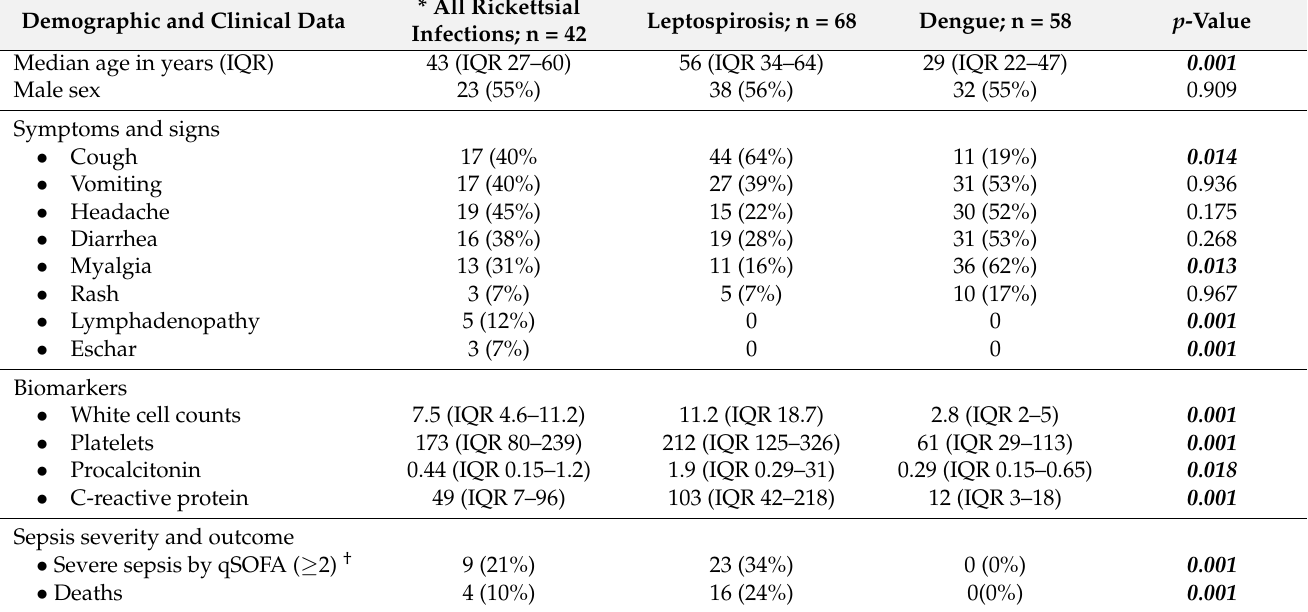
Table 2. Demographic and clinical comparisons between all rickettsial infections, leptospirosis, and